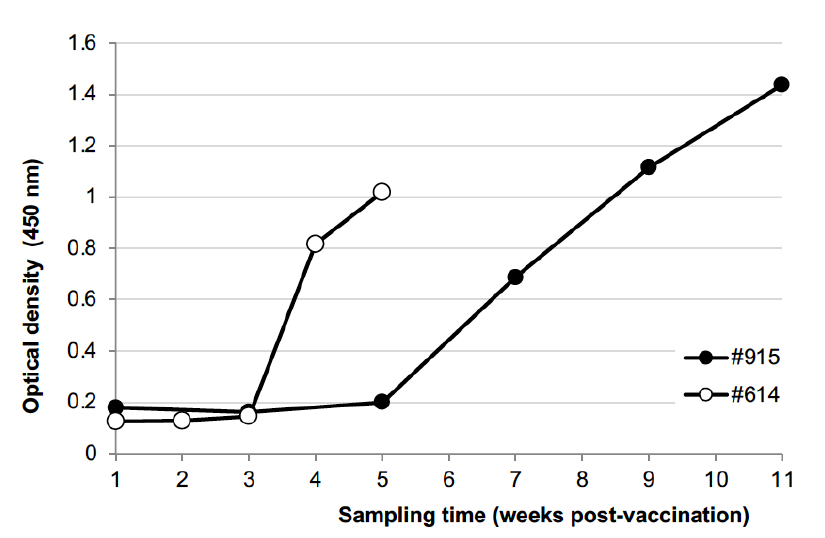
Figure 8. Ape protein induces an antibody response in sera of vaccinated goats. The antibody response to Ape protein during vaccination kinetic was tested by ELISA. Sera of vaccinated goats were incubated in wells coated with rApe, followed by incubation with anti-goat antibody coupled to HRP. Antibody response was detected by ELISA titers (optical density at 450 nm). Shown are representative results from five vaccinated goats. #614: goat vaccinated with an attenuated vaccine. #915: goat vaccinated with an inactivated vaccine. The time (in weeks) post-vaccination is indicated. Goats vaccinated with inactivated vaccine were also challenged for resistance to E. ruminantium Gardel strain seven weeks post